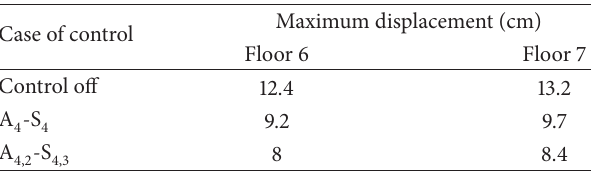
Table 10: The maximum displacements of the seven-story shear building excited by the Elcentro earthquake.